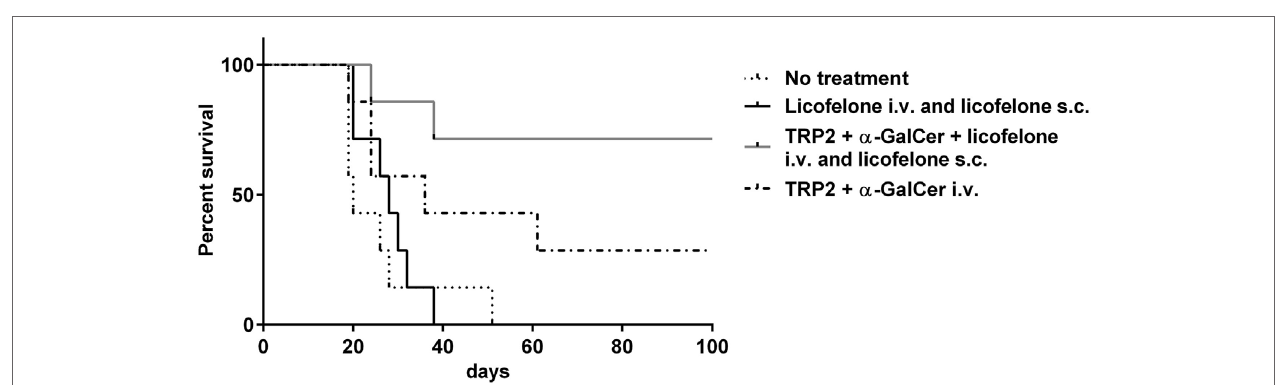
FigUre 1 | addition of licofelone to a long-peptide cancer vaccine therapy prolongs survival of melanoma-bearing mice . Groups of mice ( n = 7) were injected s.c. with 5 × 10 4 B16F10luc2 tumor cells and were subsequently left untreated or injected i.v. on day 6 with TRP2-peptide and α -GalCer in cationic liposomes or TRP2-peptide, α -GalCer, and licofelone in cationic liposomes. Mice that received a vaccine containing licofelone in cationic liposomes were also injected s.c. every second day with the licofelone formulated into cationic liposomes while a control group of mice received only s.c. injections of licofelone liposomes. The graph shows the Kaplan–Meier survival curve. Data are representative of two independent experiments with each n = 7 mice/group, *** p < 0.0001.